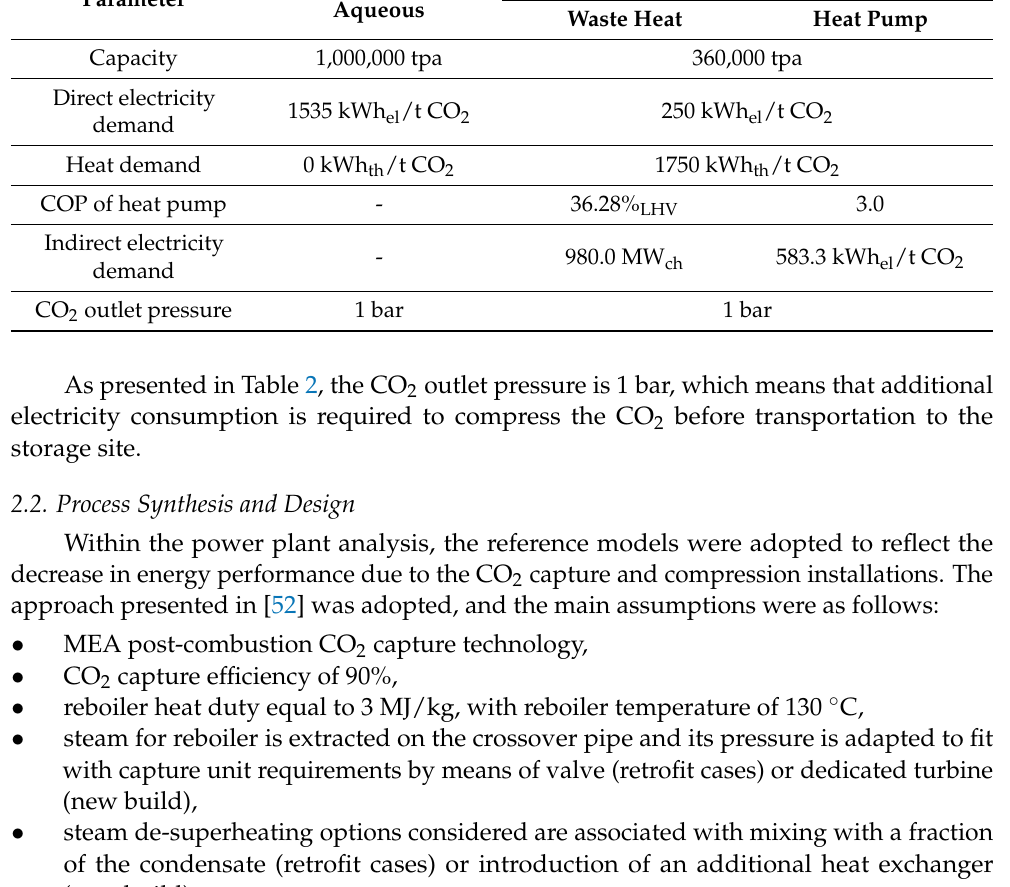
Table 2. Technical summary of analyzed direct air capture installations.